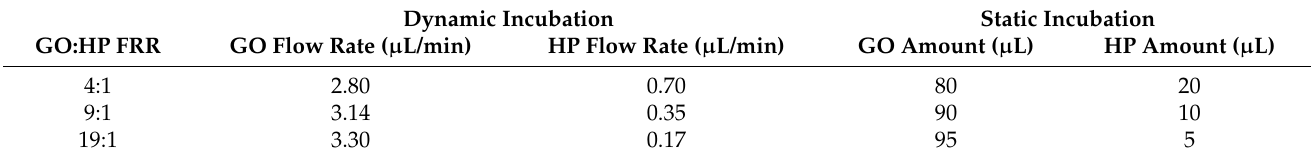
Table 1. Microfluidic and static parameters employed to explore the effects of the FRRs on the MagLev patterns of GO-HP samples. The TFR was set at 3.5 µ L/min. The GO flow rate corresponds to the sum of flow rates in the two lateral